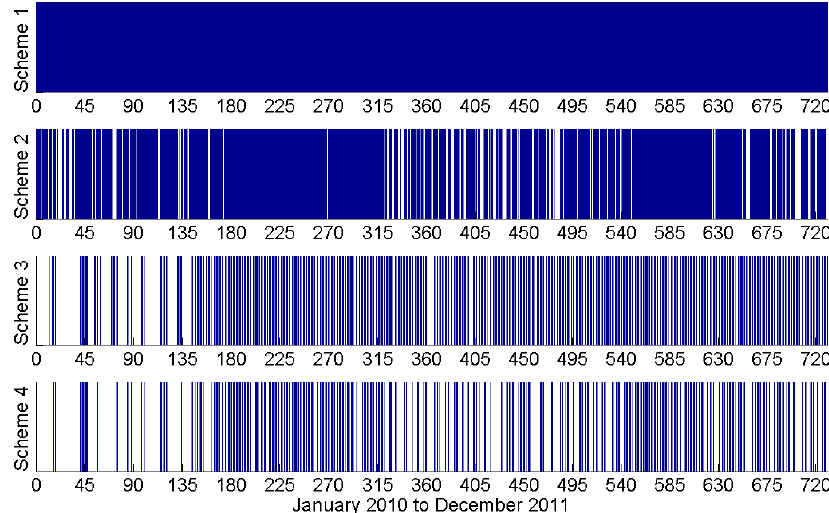
Figure 9. Data availability plots of the four schemes: scheme 1: SAC-SMA-SM input; scheme 2: SAC-SMA-SM and MODIS-LST inputs; scheme 3: SAC-SMA-SM and SMOS- T b s inputs; scheme 4: SAC-SMA-SM, MODIS-LST, and SMOS- T b s inputs. The total available days for the four schemes are 730, 458, 217, and 140 respectively.